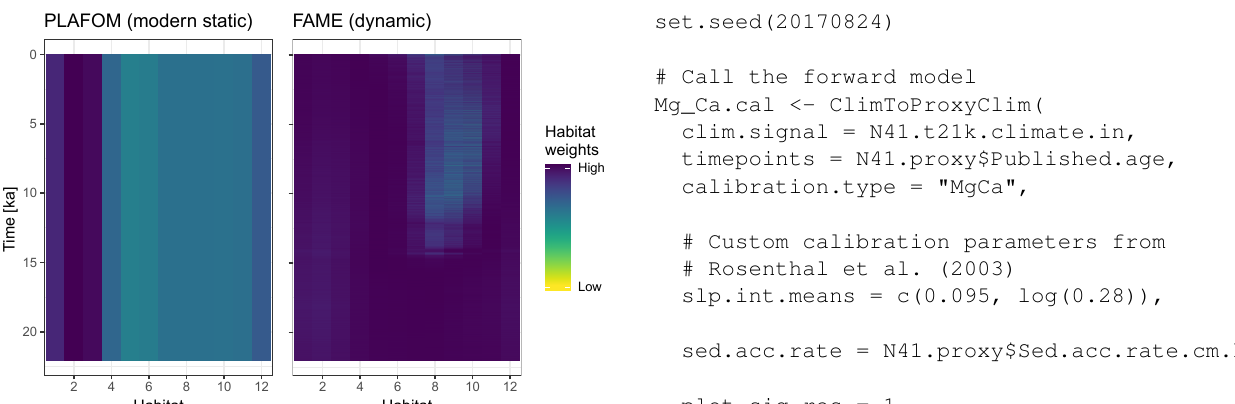
Figure 3. A forward modelled foraminiferal Mg / Ca pseudo-proxy record together with the observed Mg / Ca proxy record at core MD97- 2141 in the Sulu Sea. The input climate is shown at annual resolution with the full monthly input time series in grey.